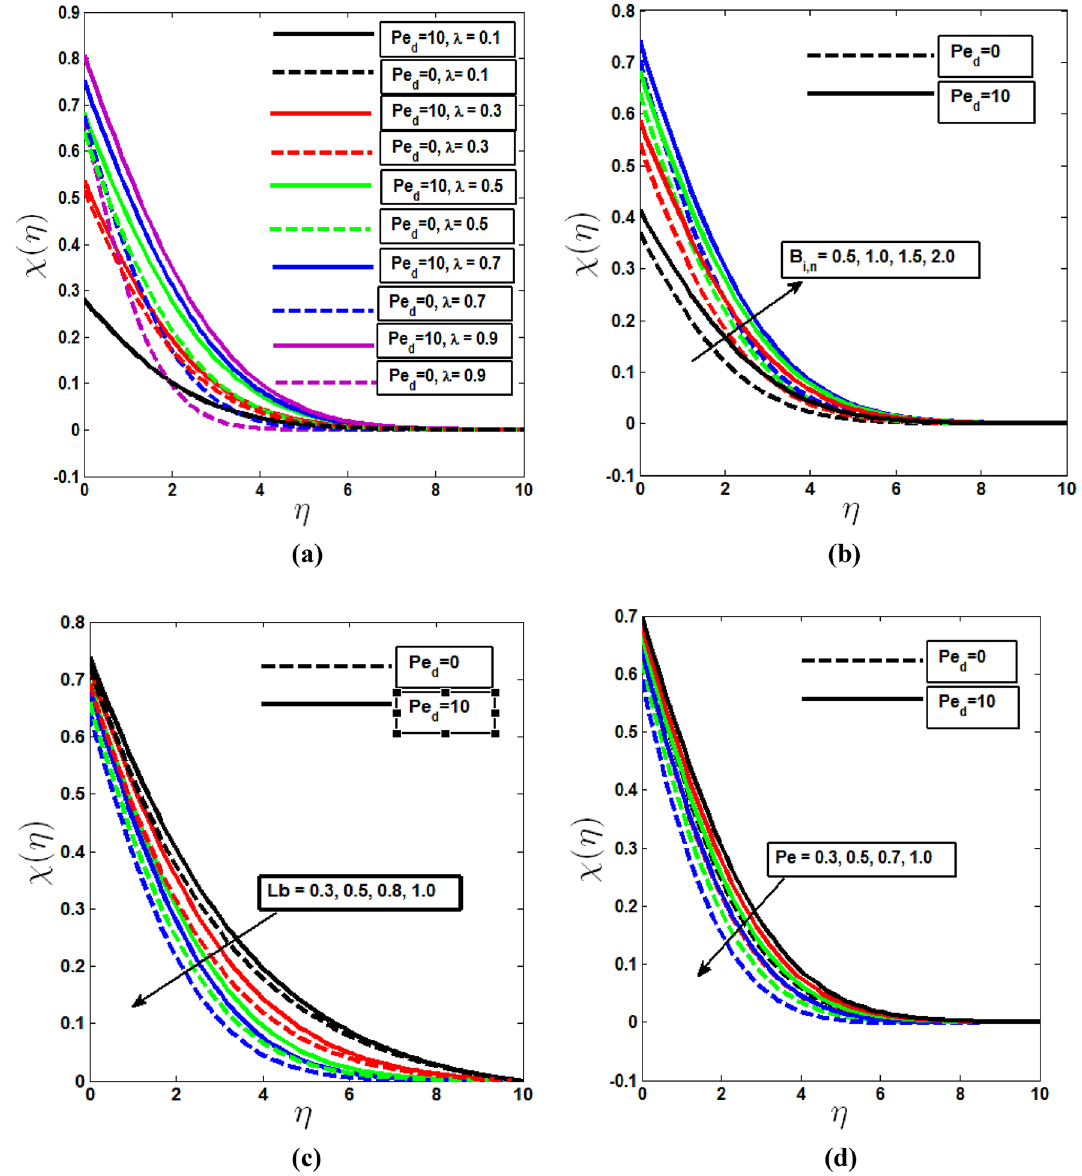
Figure 5. Microorganism profile with the ( a ) variation of mixed convection parameter, ( b ) Biot number of microorganism transfer, ( c ) Bioconvection Lewis parameter Le, ( d ) Bioconvection peclet number in the presence and absence of microorganism dispersion